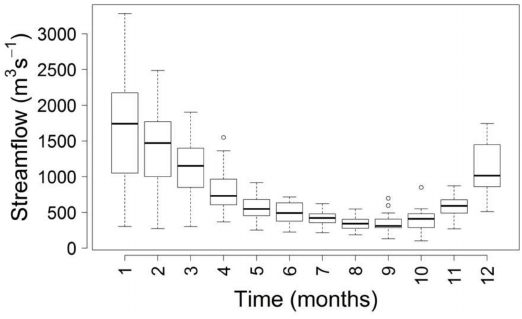
Figure 3. Boxplot of the average monthly streamflow to the Furnas HPP reservoir